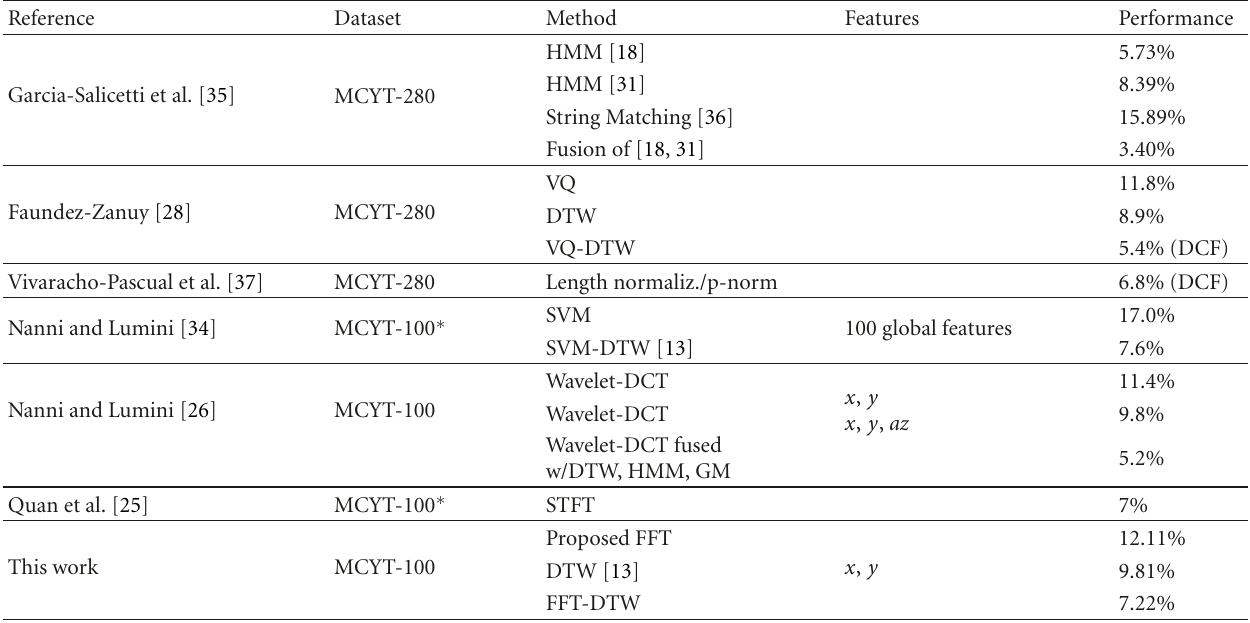
Table 6: State-of-the-art results on the MCYT database using a priori normalization techniques. Unless otherwise indicated, all dimensions of the input signal are